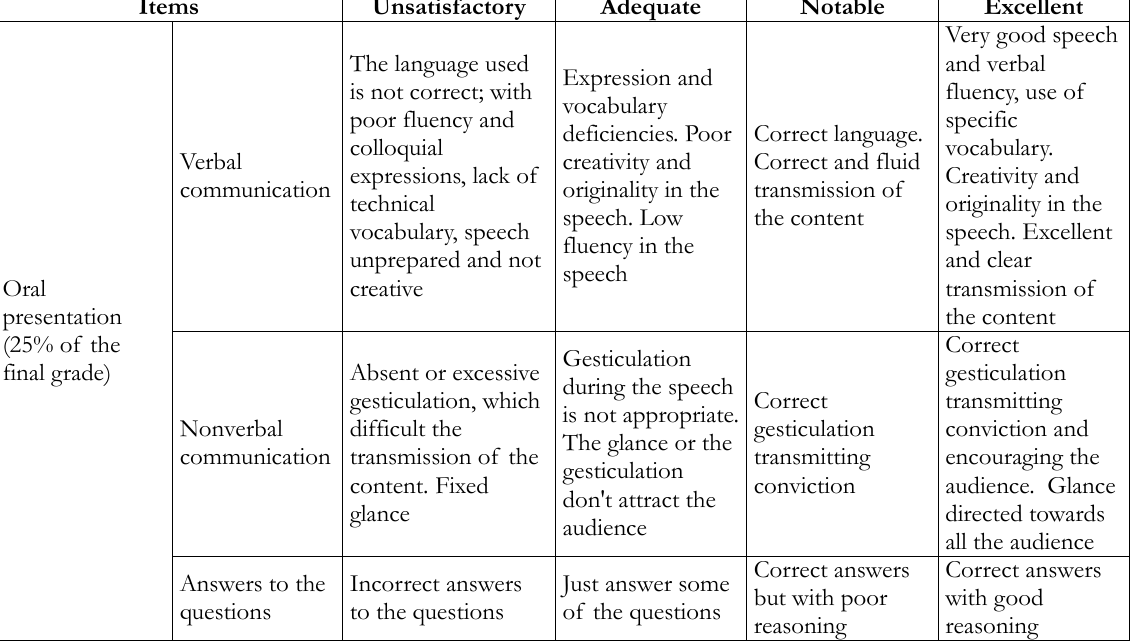
Table 1. Evaluation rubric used in the academic year 2014-2015 in General Geology in Engineering Geology